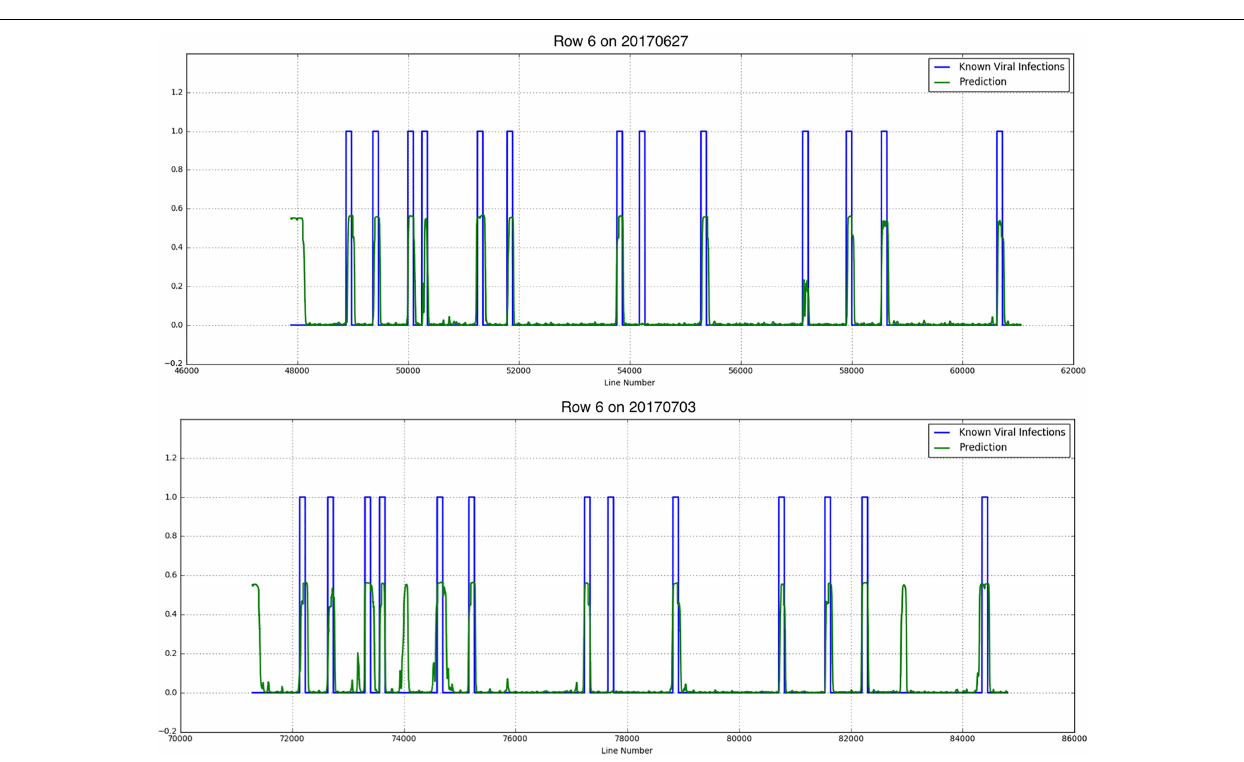
Frontiers in Plant Science |